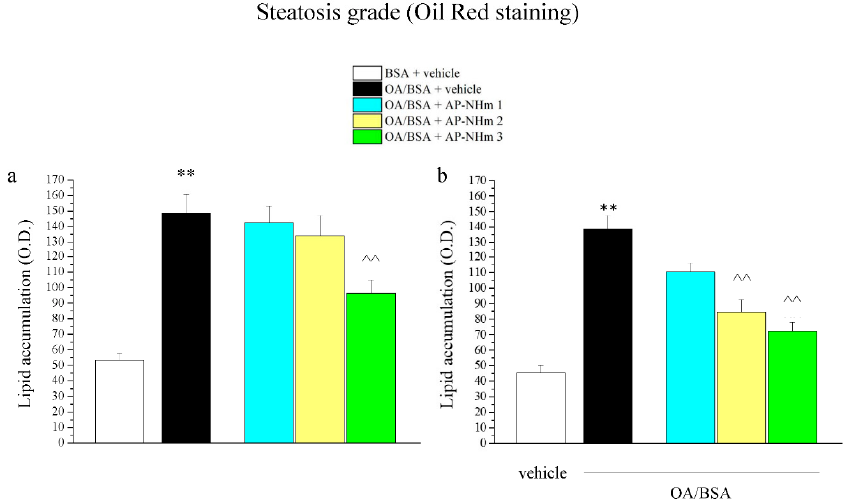
Figure 4. Effects of AP-NHm 3 on steatosis grade measured by oil red staining. HepG2 were incubated with 0.5-mM oleic acid in 1% BSA (OA/BSA) or BSA alone for 24 h in co-treatment or in post-injury recovery treatment (48 h) with AP-NHm 1, 2, 3. ( a ) optical density (OD) of lipid accumulation with AP-NHm in co-treatment regimen; ( b ) OD of lipid accumulation with AP-NHm in post-injury regimen. ** p < 0.01 vs. BSA + vehicle, ^^ p < 0.01 vs. OA/BSA + vehicle.